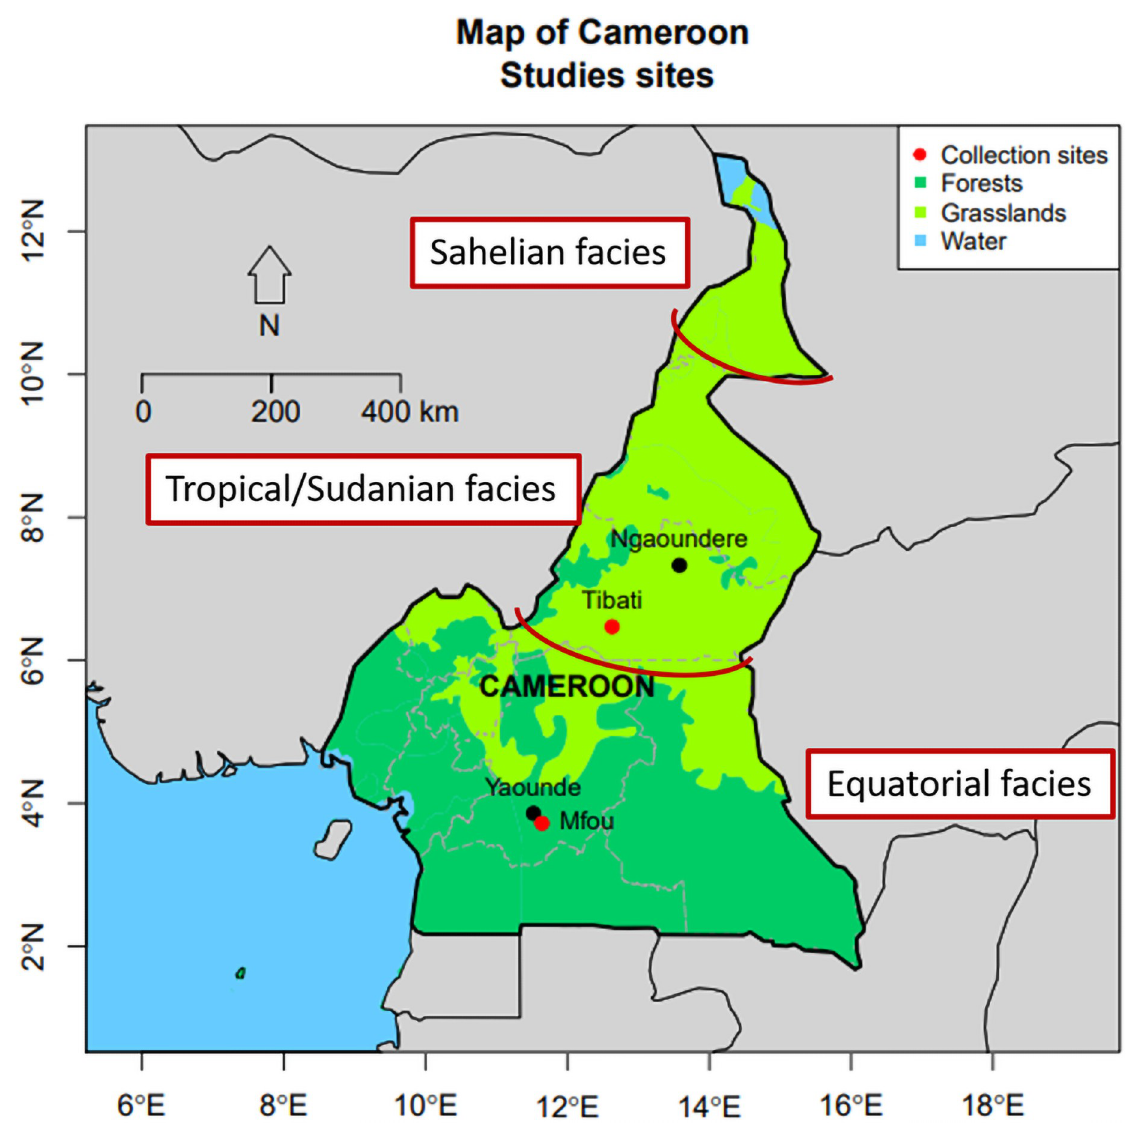
Fig 1. Map depicting the study sites in two different epidemiological settings of Cameroon. The map contains information from OpenStreetMap, which is made available under the Open Database License.